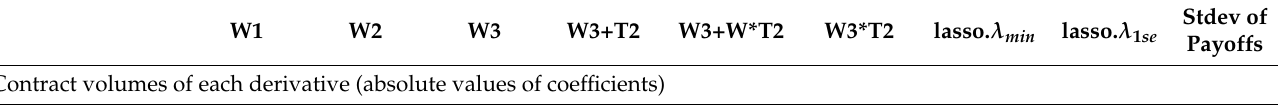
Table 3. Derivatives contract volume by hedging model, including LASSO regression-based trading